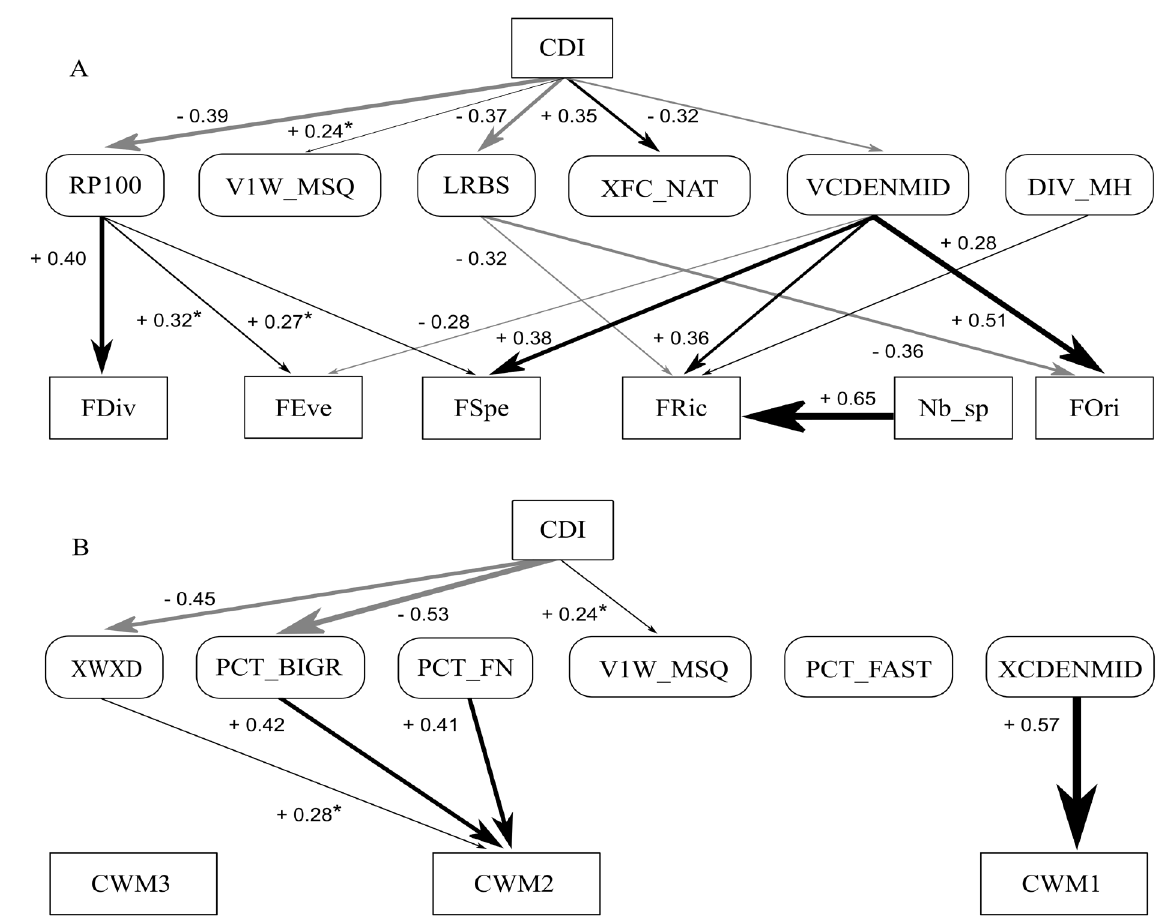
FIGURE 4 | Structural equation model diagrams showing the effects of landscape degradation (CDI) on the functional structure of stream fish assemblages from the Araguari River basin. CDI influenced functional diversity mediated by alterations in habitat heterogeneity and stability ( A. Model fit: X2 = 32.8, df = 25, p = 0.51). CDI also influenced functional identity, mediated by changes in habitat type ( B. Model fit: X2 = 44.9, df = 18, p = 0.13). Arrows indicate positive (black) and negative (gray) significant direct effects (p < 0.05; *p < 0.10), with thickness proportional to their power (standardized path coefficients along arrows). Biodiversity metrics – FRic: Functional Richness; FDiv: Functional Divergence; FEve: Functional Evennes; FSpe: Functional Specialization; FOri: Functional Originality; CWM1-3: Functional Identity. For physical-habitat codes, calculation and ecological meaning, see Tab.